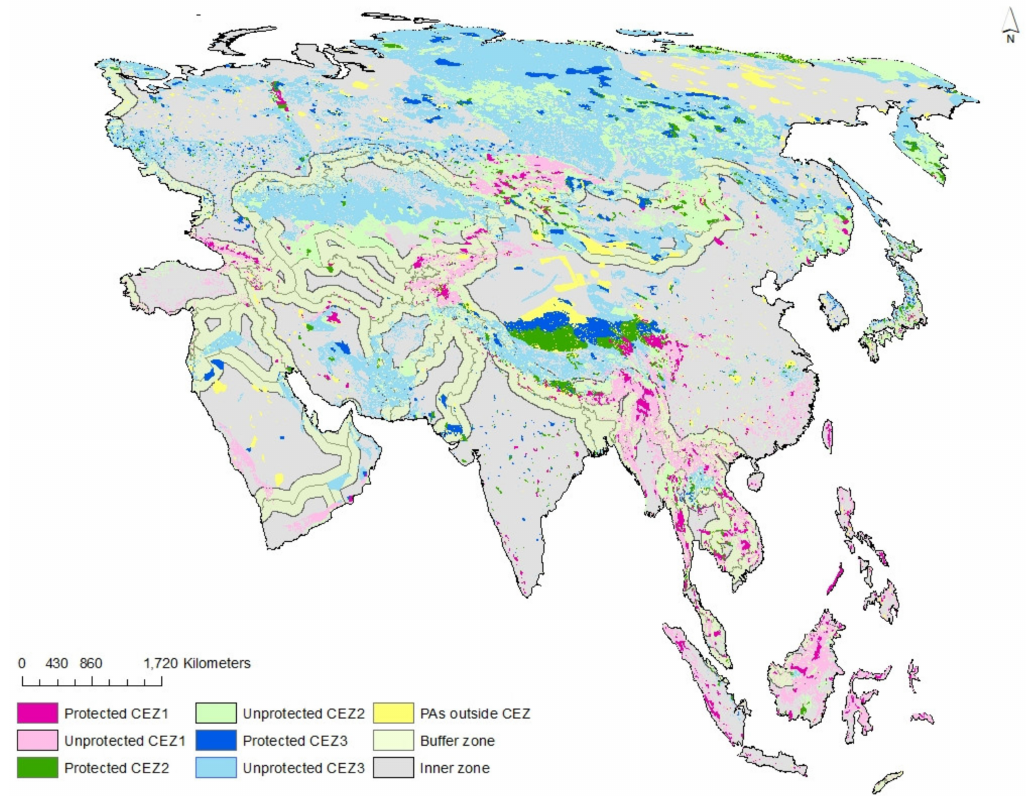
Figure 2. CEZs’ distribution in the extent of the study area with a border buffer of 125 km (light green) applied to each country. CEZ1 (light pink), CEZ2 (light green), and CEZ3 (light blue) are uncovered by existing PAs and are feasible for PAs expansion. Existing PAs in each CEZs are represented in darker colours. PAs (yellow) represent current PAs located outside the